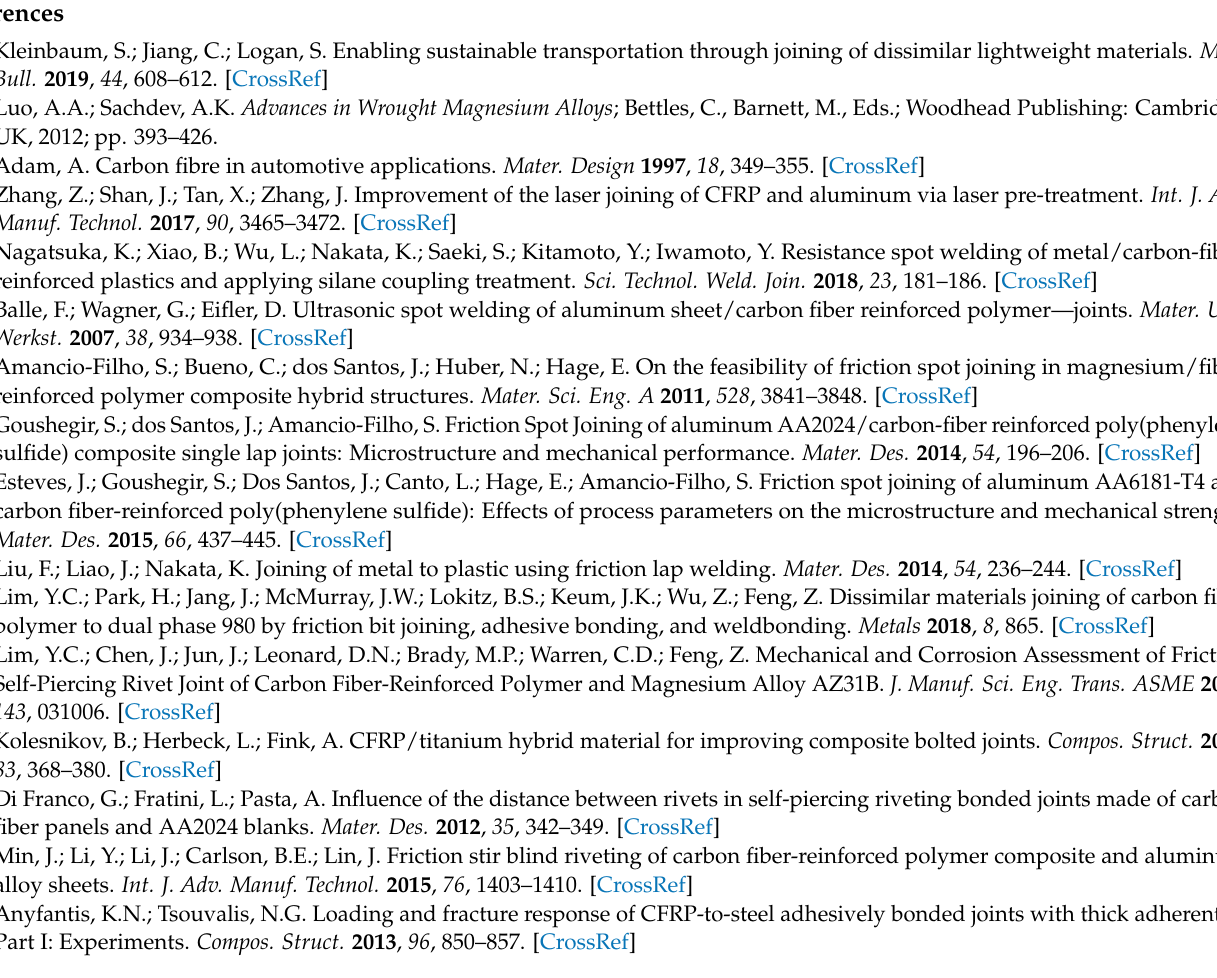
cross-tension joints under different conditions, Figure S3: Example optical profilometry measurement, Table S1: Chemical analysis of the tap